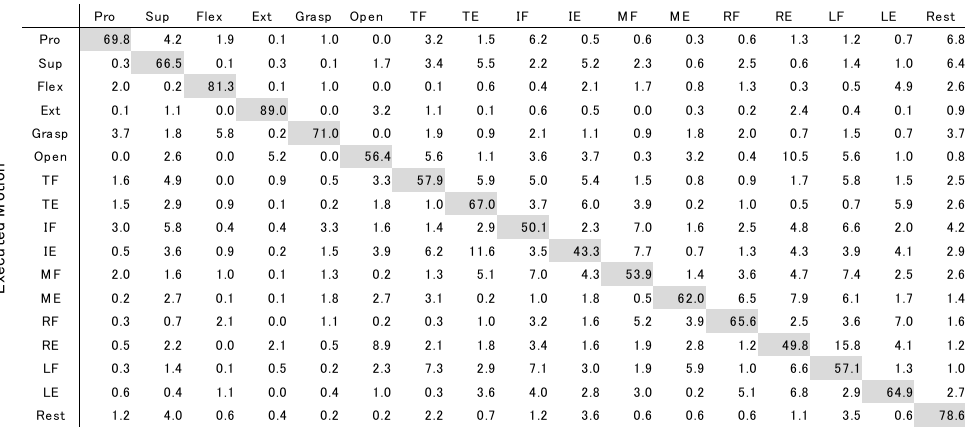
Figure 15. Confusion matrix of classification performance across subject. The 17 motions include pronation (pro), supination (sup), flexion (flex), extension (ext), hand grasping (grasp), hand opening (open), thumb flexion (TF) and extension (TE), index finger flexion (IF) and extension (IE), middle finger flexion (MF) and extension (ME), ring finger flexion (RF) and extension (RE), little finger flexion (LF) and extension (LE), and rest state (rest).